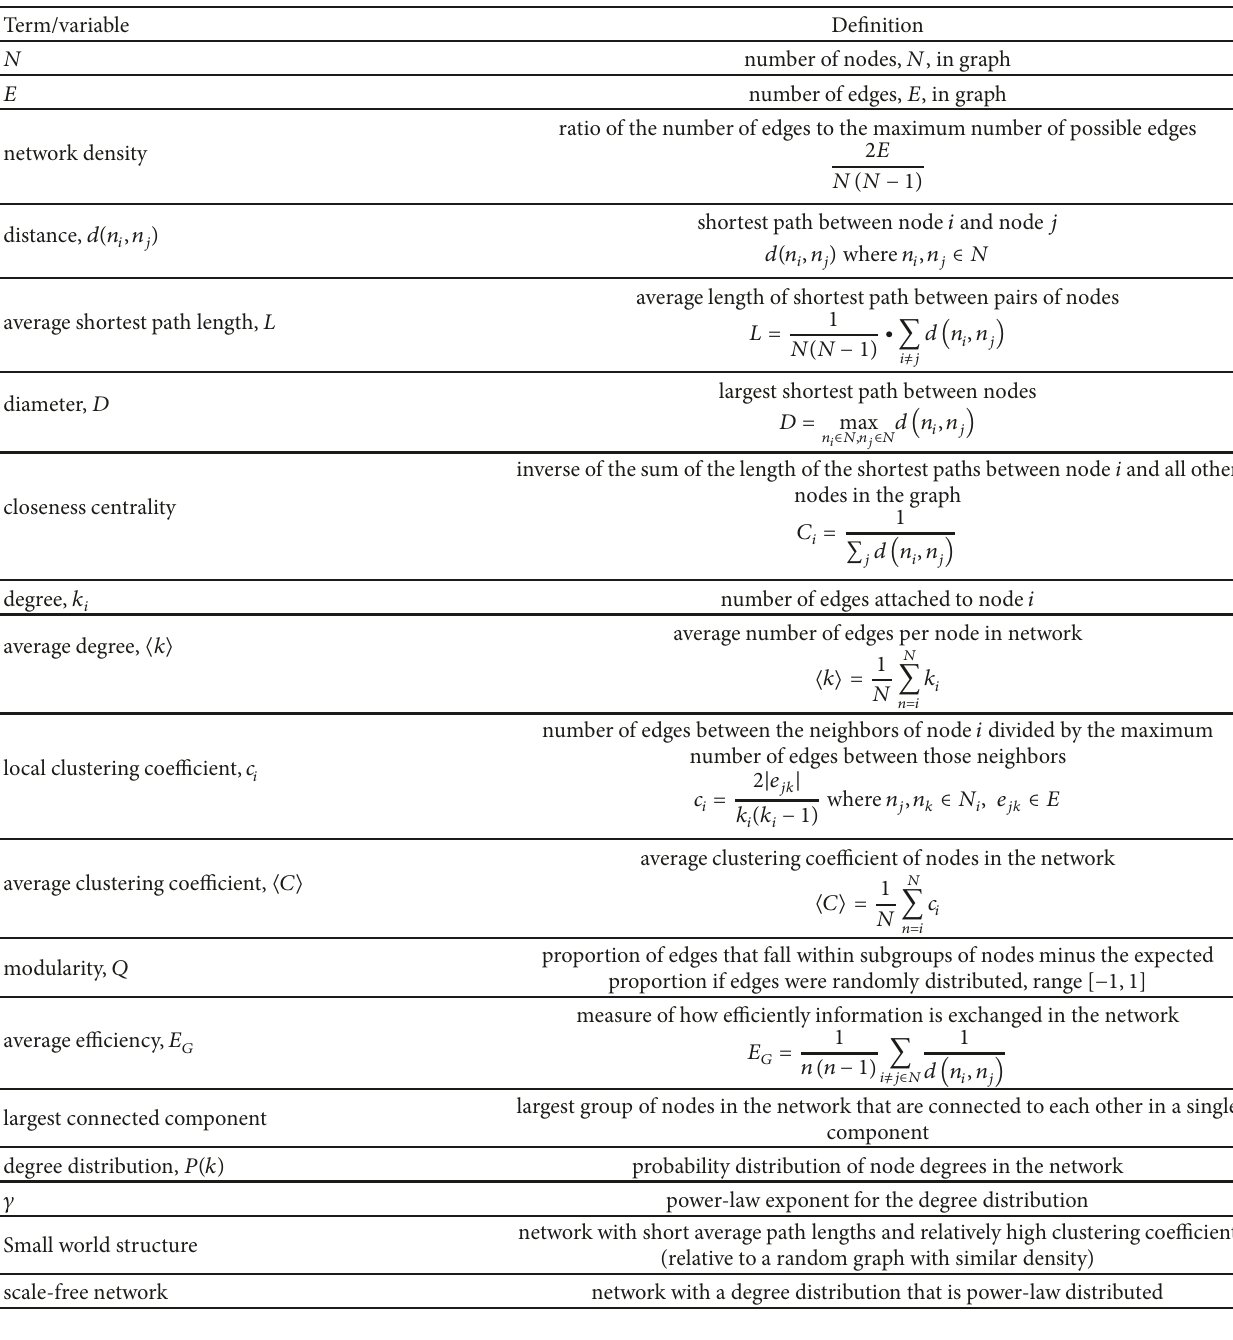
Table 2: Definitions of network science terms and